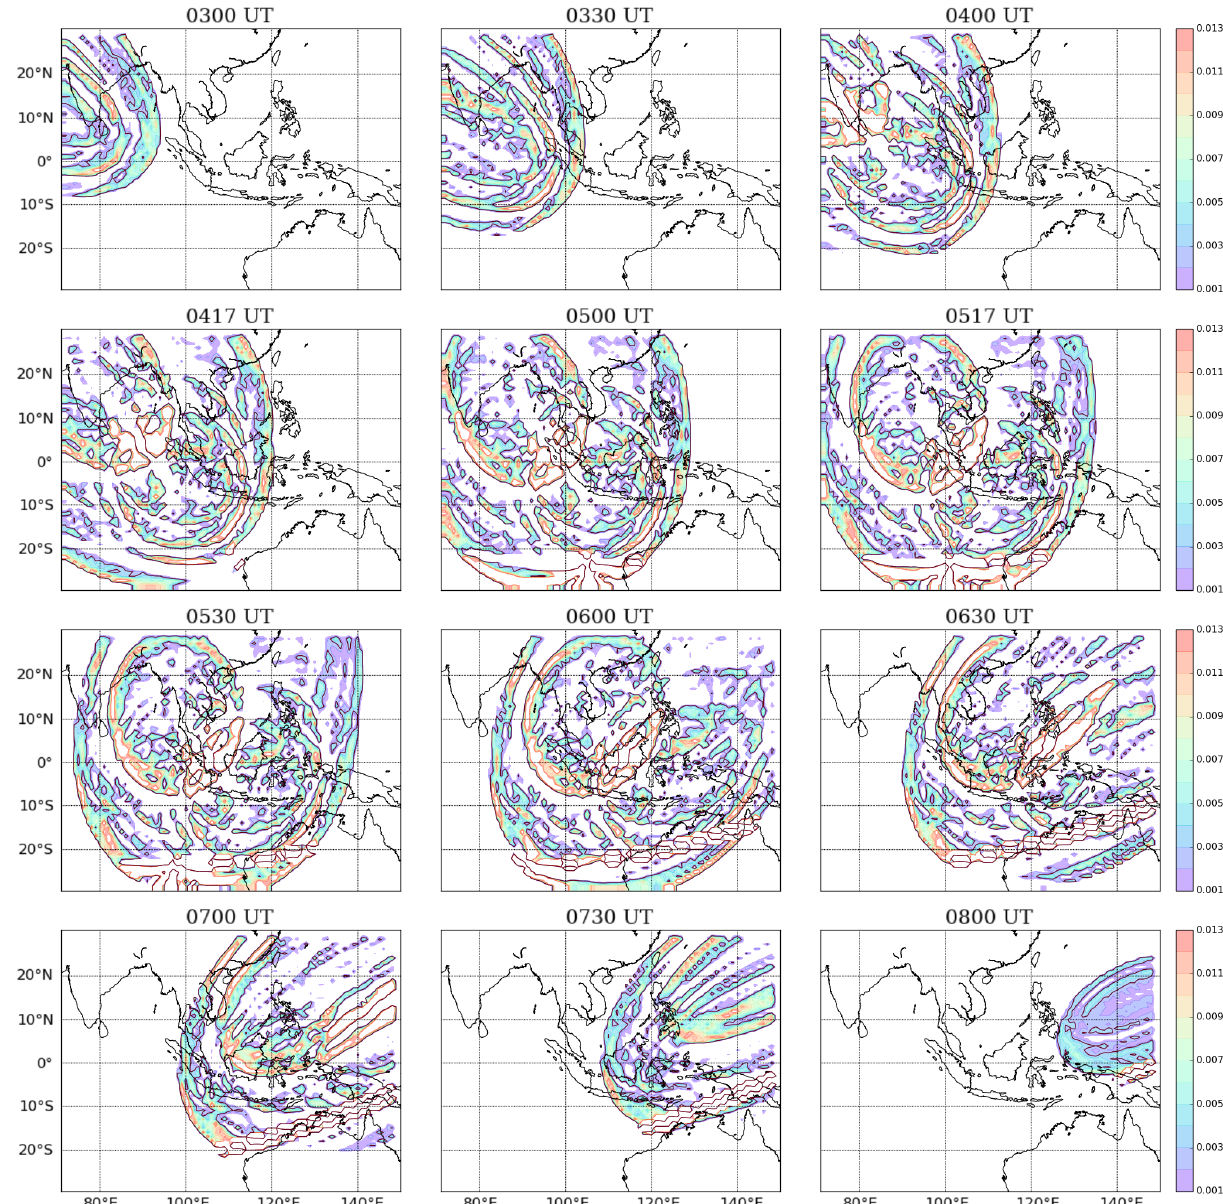
Figure 16. Sequential snapshots of spatial inhomogeneities in the solar EUV illumination pattern over Southeast Asia on 26 December 2019 as the annular solar eclipse traversed through the region. Contours and color map indicate the absolute magnitude of the Laplacian of the solar EUV irradiance distribution over a geographic latitude–longitude grid at 100km